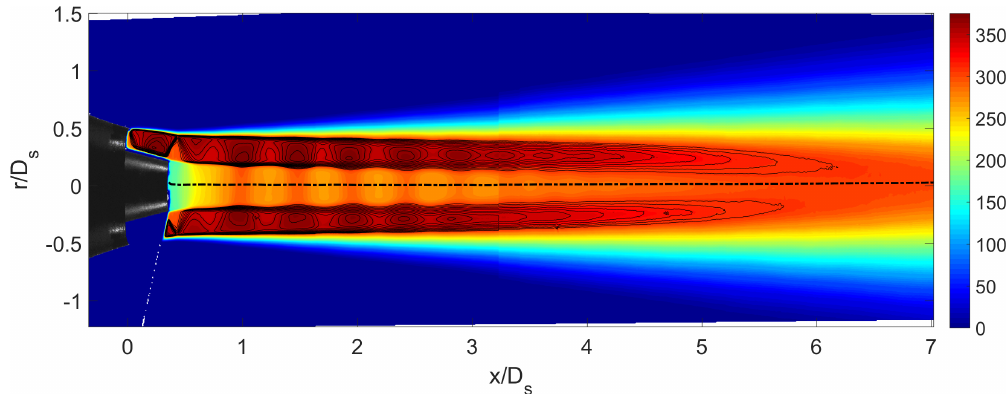
Figure 28. Averaged velocity fields with Mach > 1 isolines. Based on the radial velocity profiles, the white dashed line is the estimated jet axis. A strong, oblique, shock-wave is present at the end of the primary lip, as expected from simulations. The shock-wave is refracted by the shear layer as a series of expansion waves, which lead then to the formation of the shock-cell system. The shock-cells surround the primary flow and exhibit a regular pattern until the eighth shock-cell. The primary flow velocity is modulated in space following the shock-cells pattern. Some asymmetry is visually perceivable, although a more quantitative approach is requested in order to understand the influence on the flow topology and on the jet